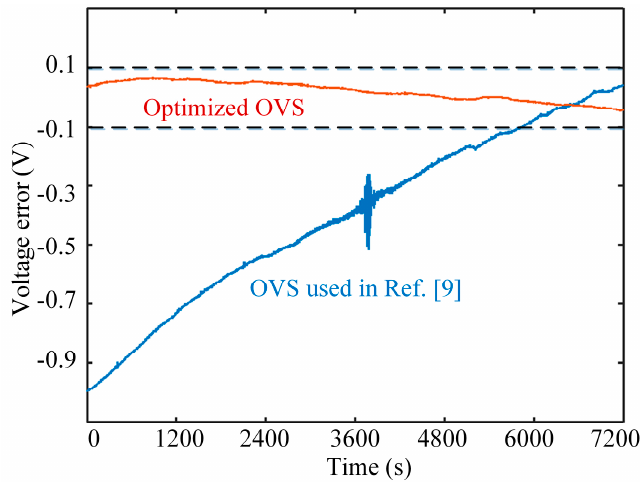
Figure 7. Comparison between the bias stability of the optimized OVS and the previous OVS used in Ref. [9].